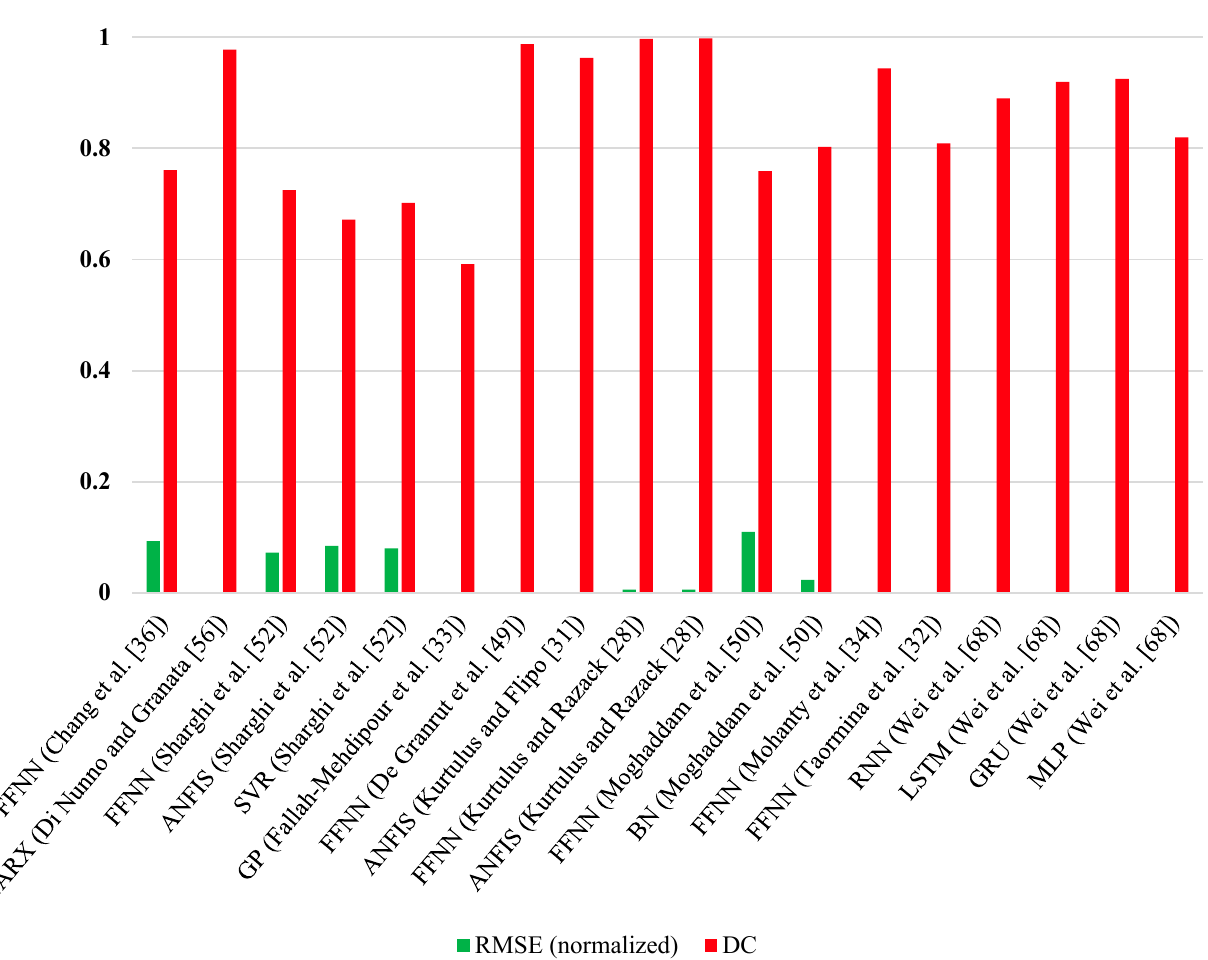
Figure 9. Comparative performance analysis of single soft computing methods.